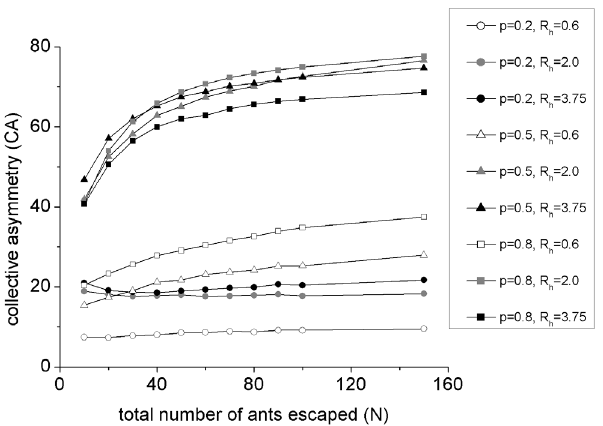
Fig. 3. Percentage of CA vs : N of Vicsek-like model. p is assigned a value of 0.2 (circle or dots), 0.5 (triangle) and 0.8 (square). R h is assigned a value of 0.6 (hollow), 2.0 (gray) and 3.75 (black). The black square ( p ~ 0 : 8 , R h ~ 3 : 75 ) corresponds to parameter values as in Altshuler’s model (11). All the points are averaged over 10000 runs of simulation.